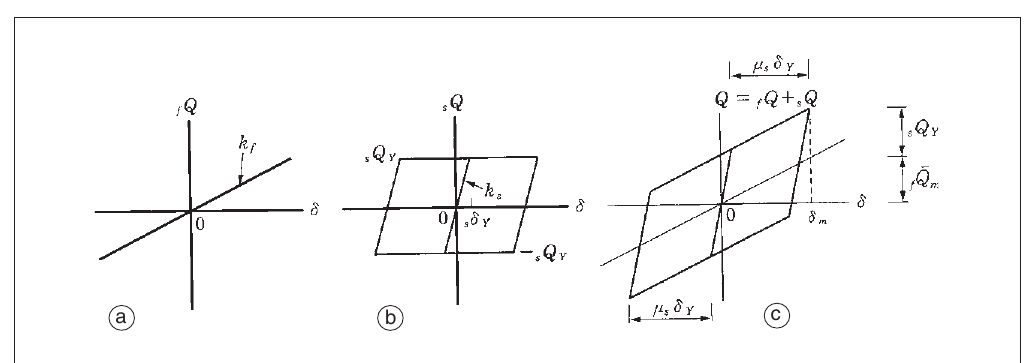
Fig. 3a-c. a) Flexible element; b) stiff element; c) mixed